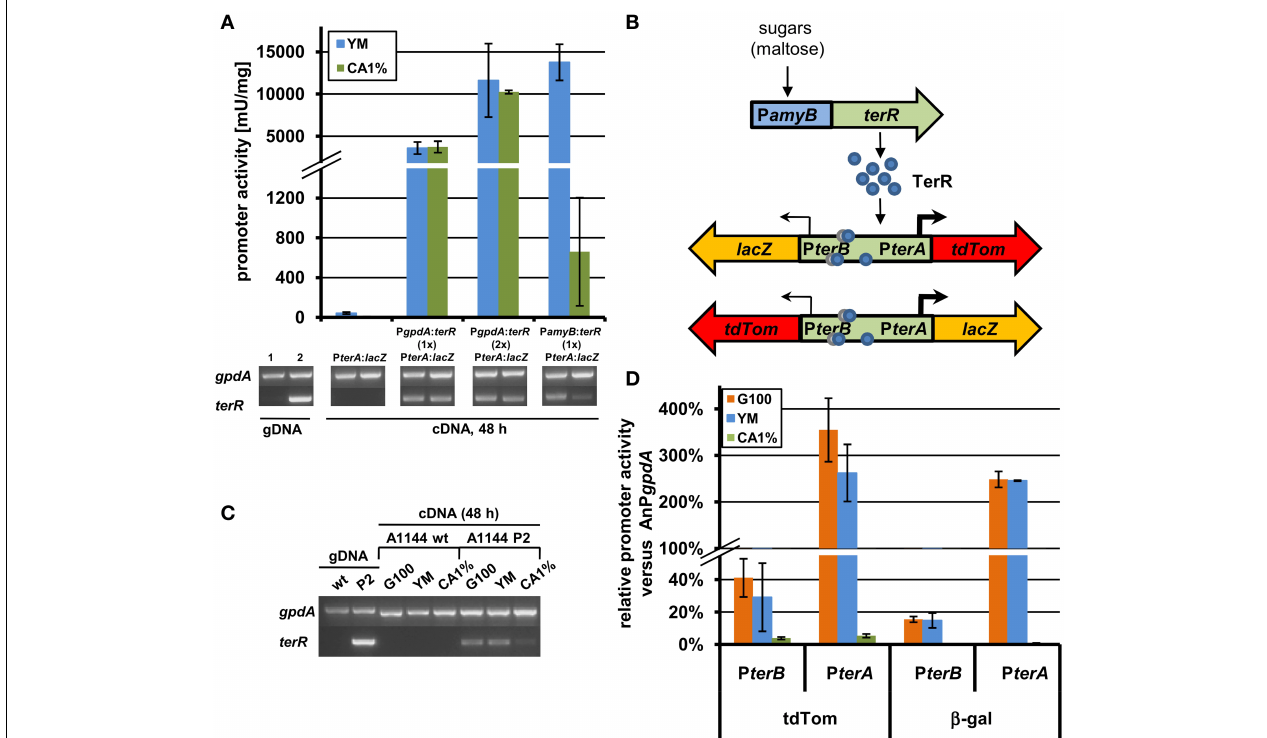
FIGURE 4 | Analysis of recombinant terR and terA expression in A. niger by semiquantitative RT-PCR, LacZ, and tdTomato reporter activity. (A) Semiquantitative RT-PCR (lower panels) and β -galactosidase activity (upper panel) of A. niger A1144_P terA : lacZ either without terR or co-expressing the terR gene under control of the A. nidulans gpdA promoter (P gpdA:terR , P terA:lacZ ; with one (1 × ) or two (2 × ) copies of P gpdA:terR )